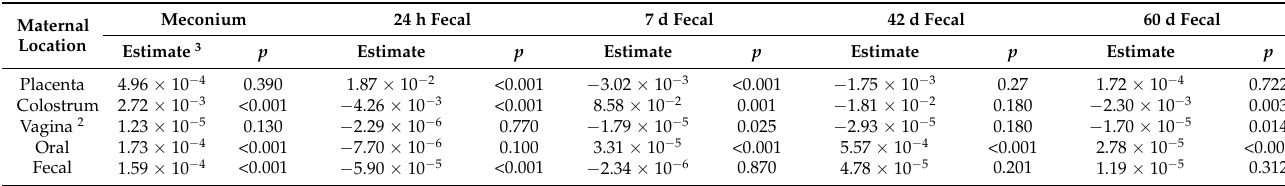
Table 4. Coefficient estimates for negative binomial regression models between maternal microbiomes and calf fecal microbiomes from multiparous Holstein cow–calf pairs ( n = 6) 1